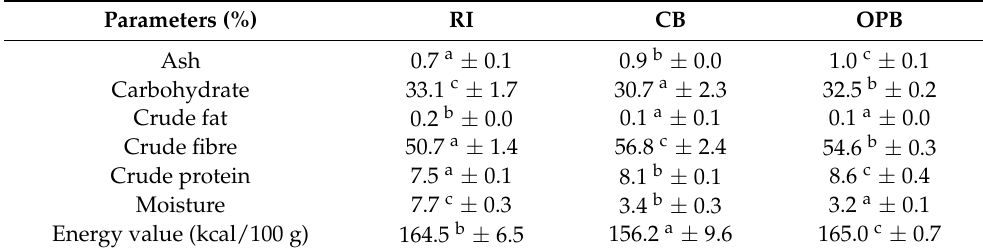
Table 1. Proximate compositions of umqombothi